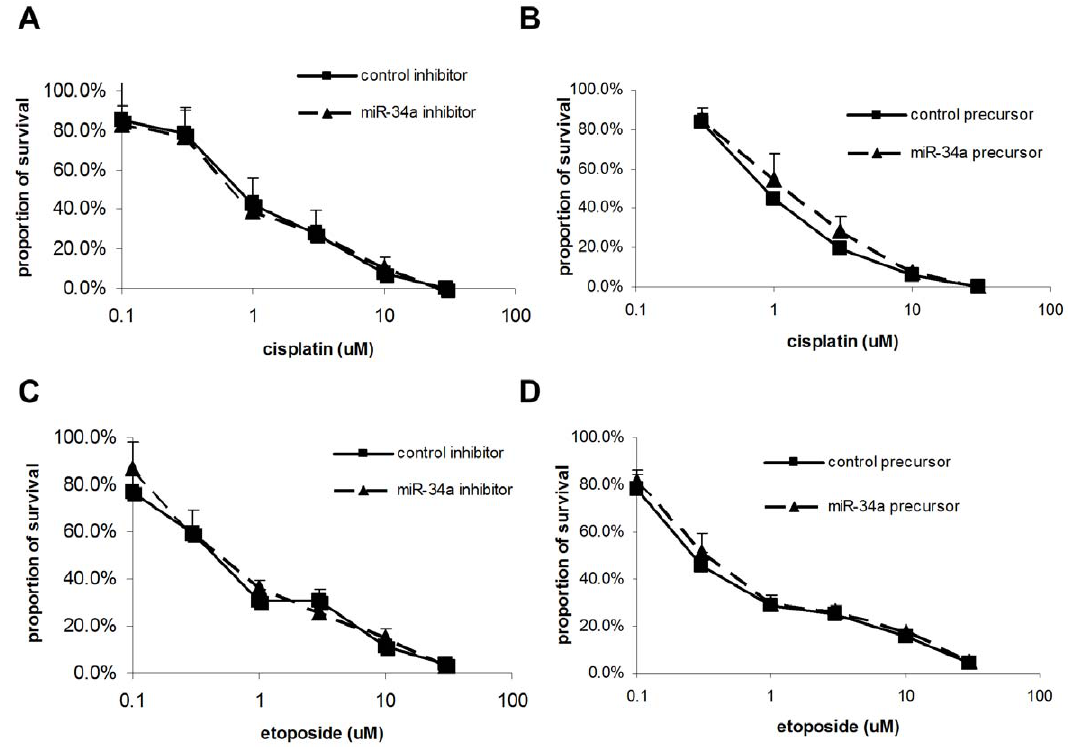
Figure 2. Growth inhibition assay of NCI-H82 cells treated with (A and B) cisplatin and (C and D) etoposide. Cells were transfected with the indicated oligonucleotides. Error bars indicate standard deviation of assays in triplicate.